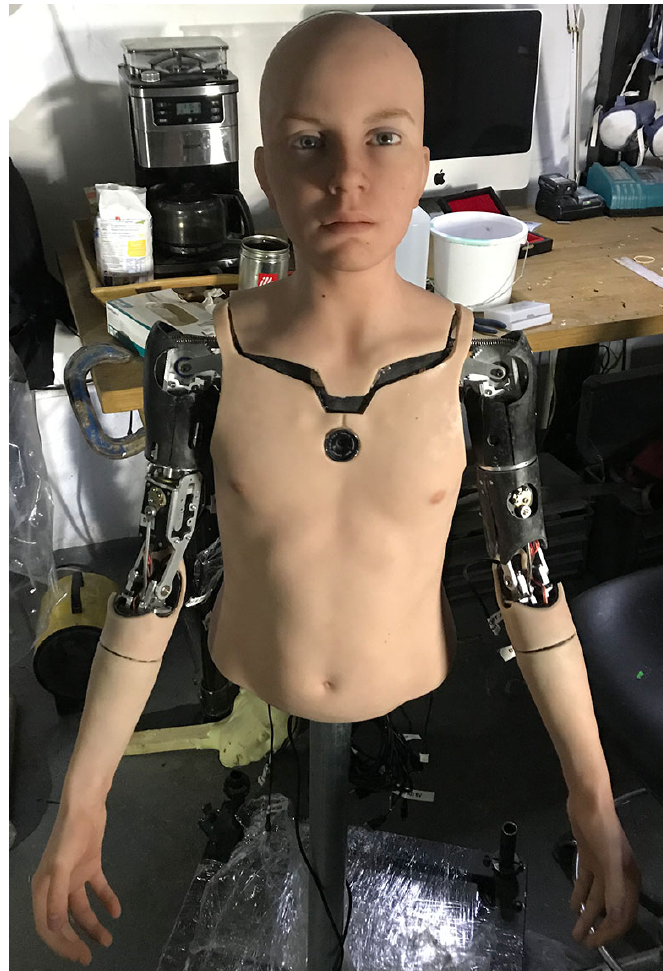
Figure 4. A picture of Abel at the current stage of